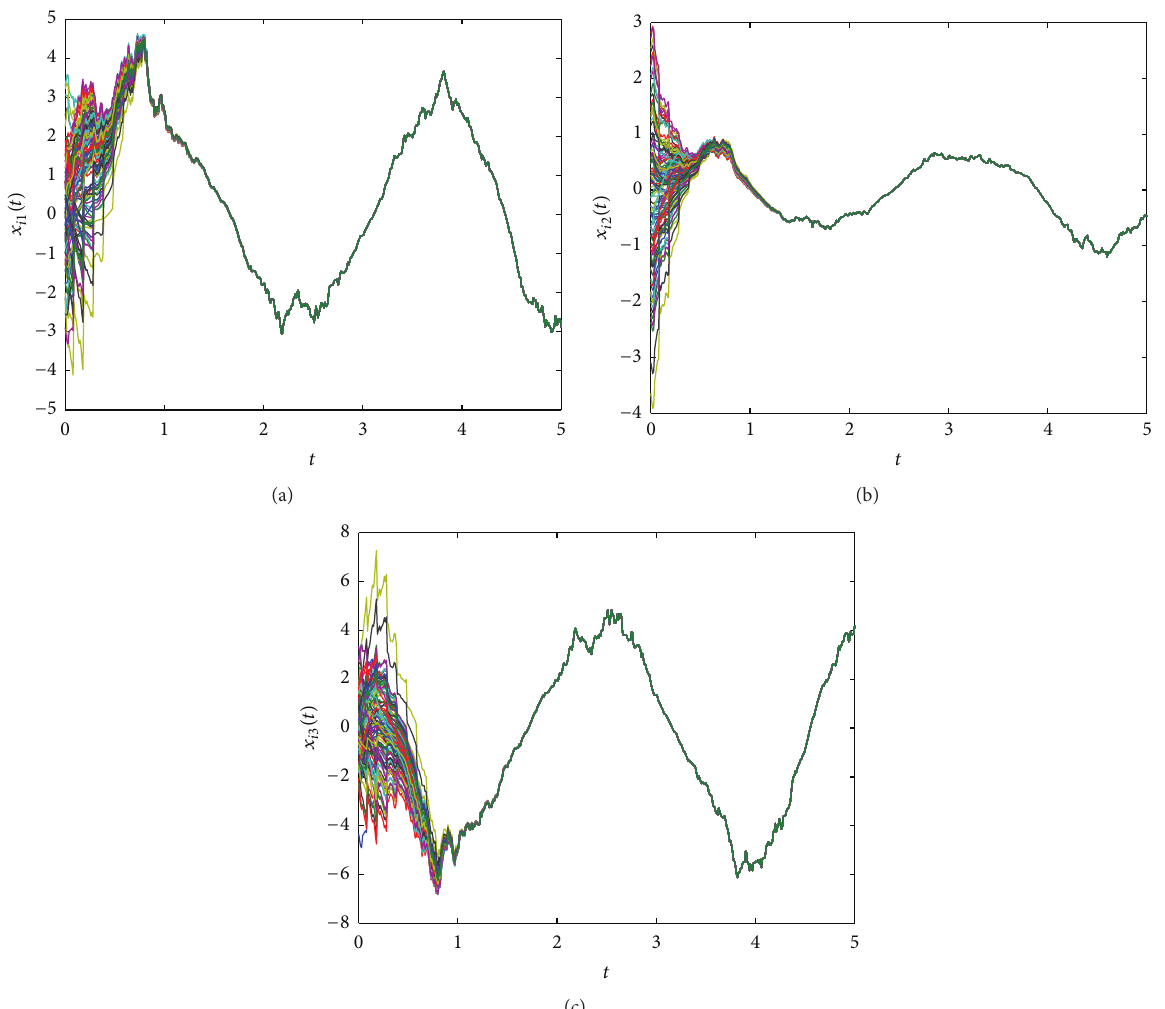
Figure 2: State variables 𝑥 𝑖 (𝑡), 𝑖 = 1, 2, .. ., 100 of the coupled dynamical network with impulsive disturbances when |𝜇| < 1 .